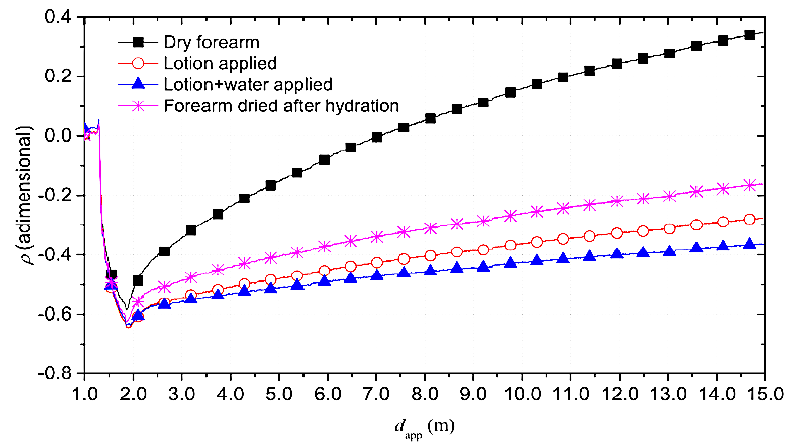
Figure 17. TDR reflectograms obtained in the four conditions described above [48].